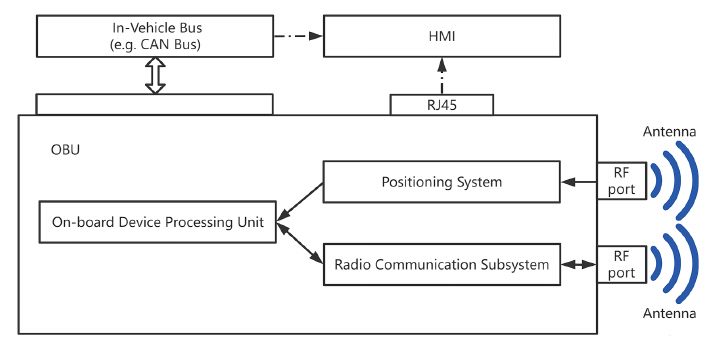
Figure 2. Basic components of the